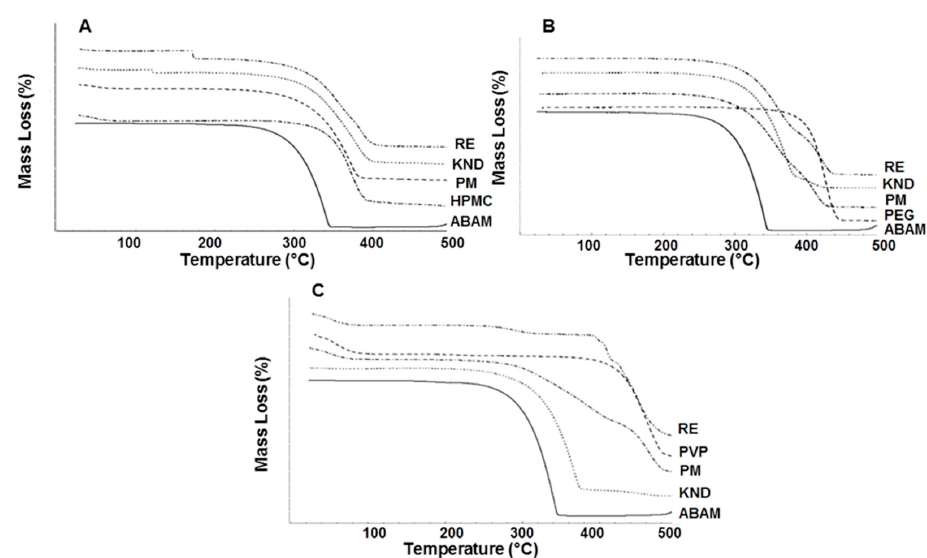
Figure 4. ( A ) TG curves for ABAM and HPMC alone, as well as PM and SDs prepared by KND and